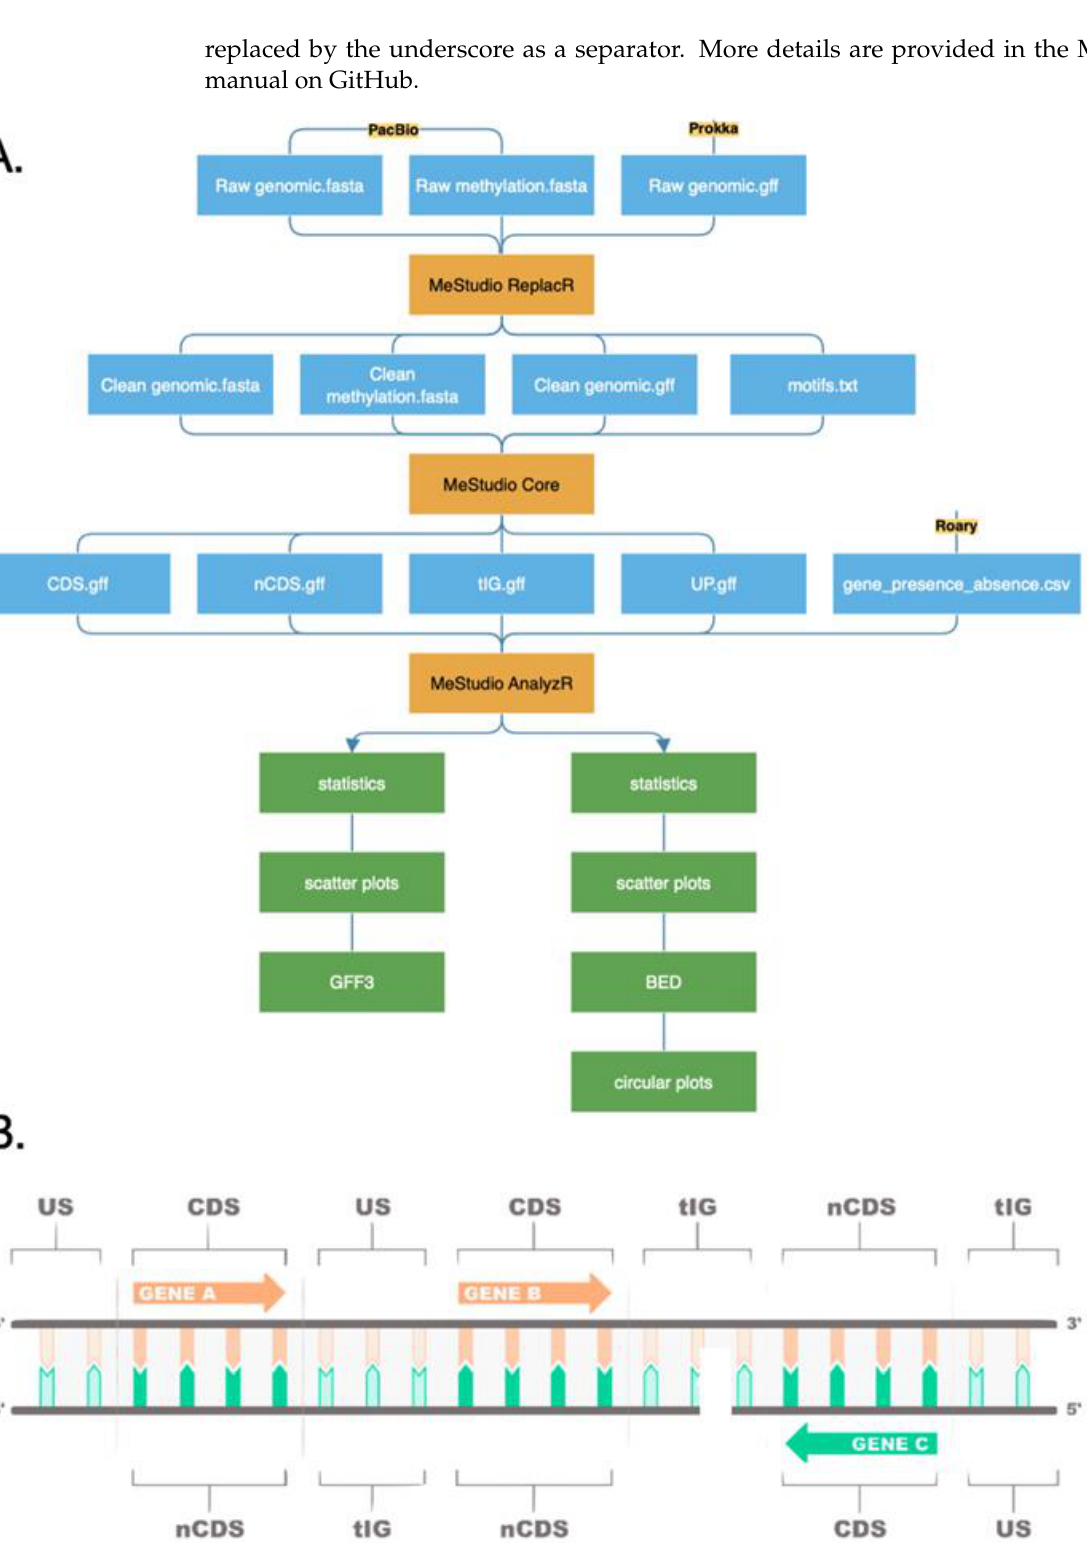
Figure 2. MeStudio overview. ( A ) Workflow. Each blue block represents input files. The orange blocks indicate the scripts. The green boxes indicate output files. ( B ) Graphical representation of the used terminology: CDS, coding sequence; nCDS, coding sequence opposite strand; tIG, intergenic sequence between two genes in opposite directions; US, upstream sequence to a coding sequence (intergenic sequence between two genes having the same orientation). See text for details.